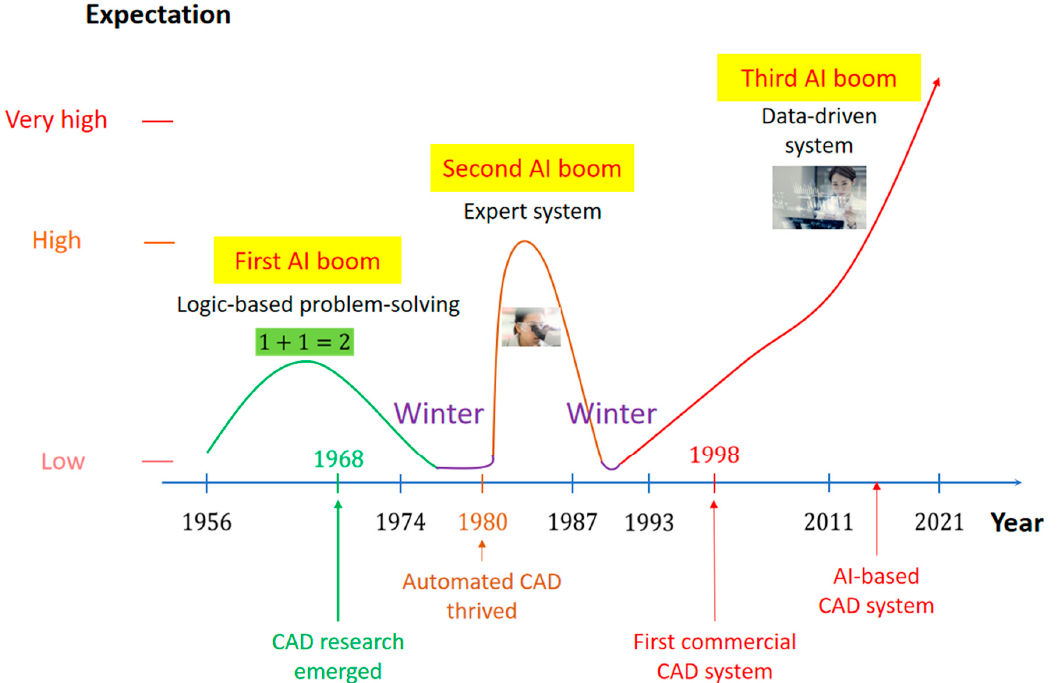
Figure 2. Timeline of AI development with two AI booms in the past and the current third AI boom. Advances in CAD research are intertwined with advances in AI